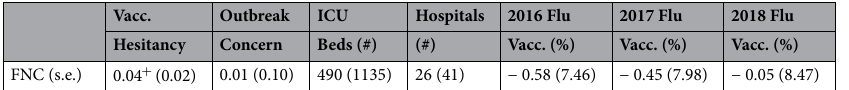
Vacc. Beds (#) (#) Vacc. (%) Vacc. (%) Vacc. (%) FNC (s.e.) Table 1. Further outcome measures. Two Stages Least Squares (2SLS) estimates of the effect of FNC’s viewership on further outcome measures. Viewerships are instrumented using the lineup channel positions. Regressions include demographic and cable-system controls. Standard errors are clustered by state. Estimates are relative to a one s.d. increase in the network’s viewership. + p < 0.10 , ∗ p < 0.05 , and ∗∗ p < 0.01 .